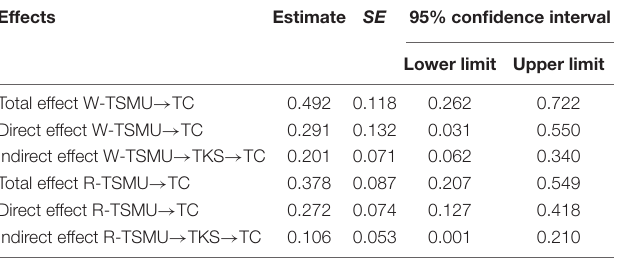
TABLE 4 | Results of mediating effects test.